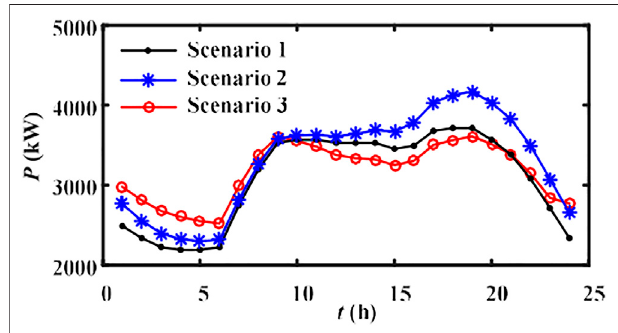
FIGURE 15 | Load curves under different